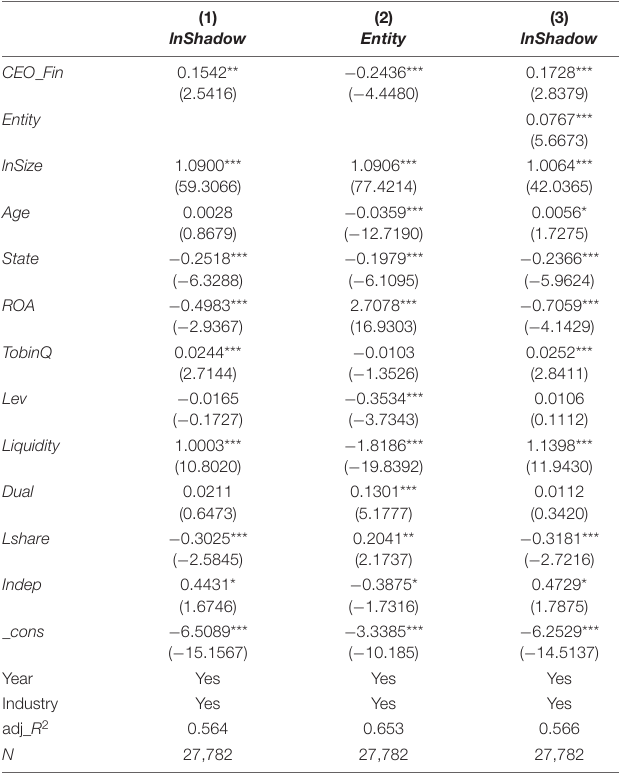
TABLE 7 | CEOs’ FB, entity investment level, and shadow banking business of non-financial